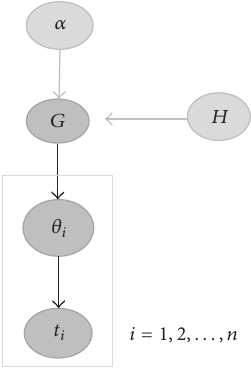
Figure 1: Graphical Dirichlet Mixture Model.